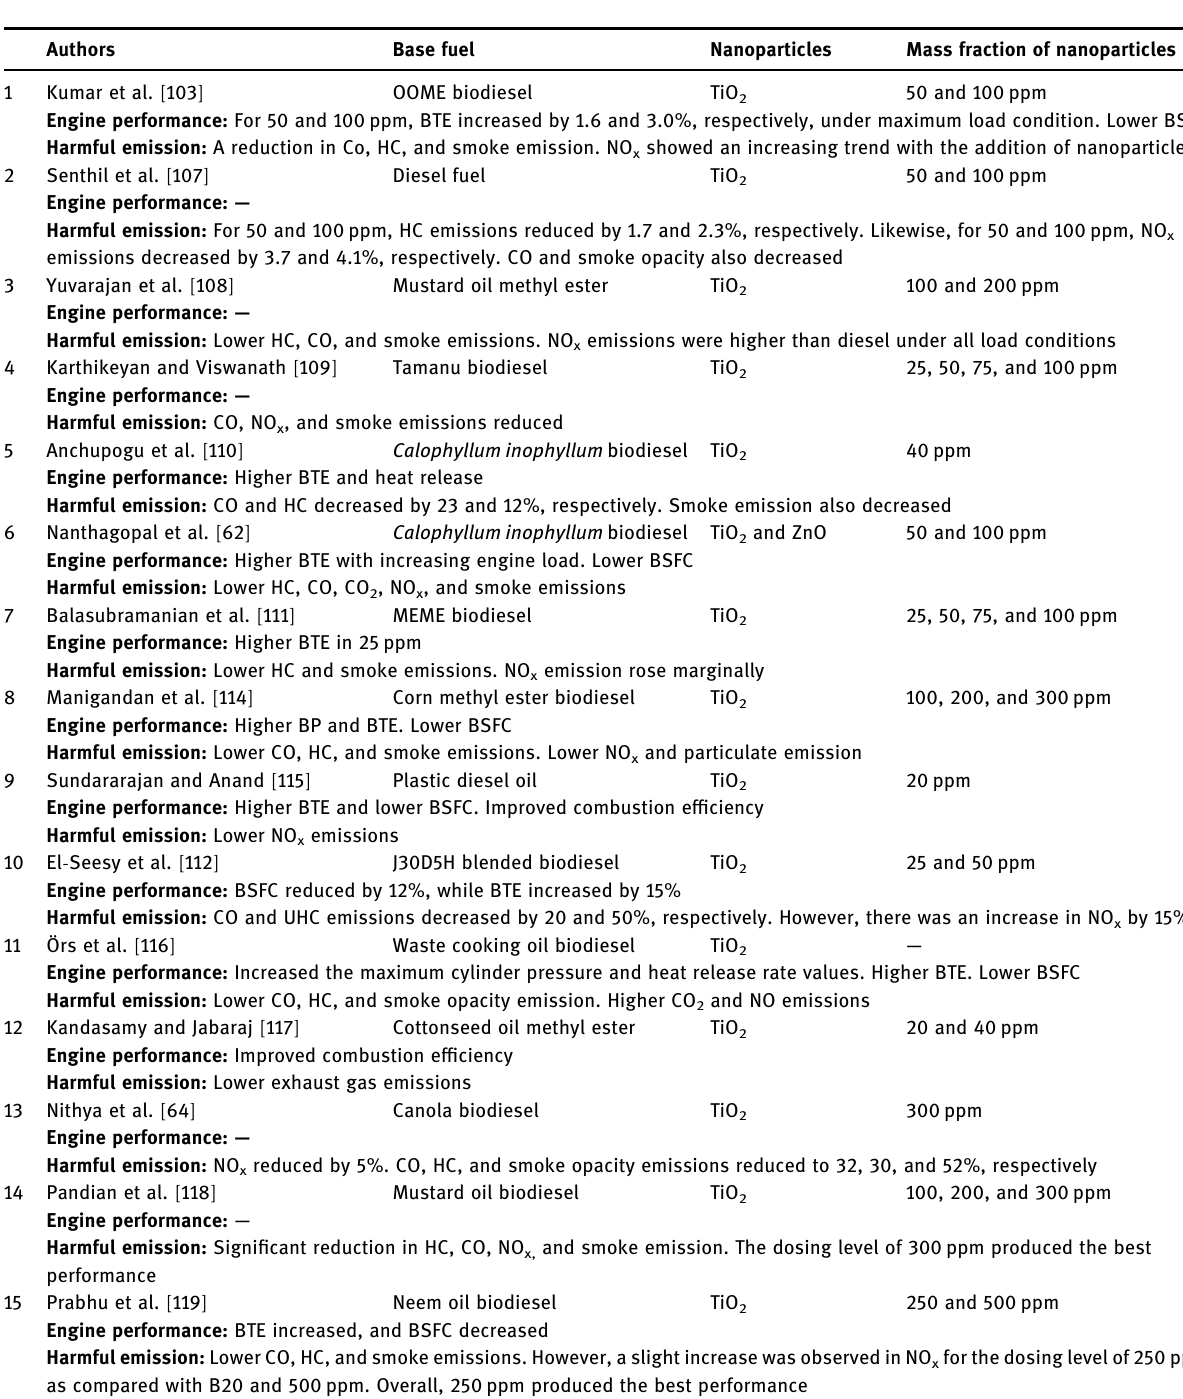
Table 4: Summary of TiO 2 nanoparticles as an additive in diesel/biodiesel